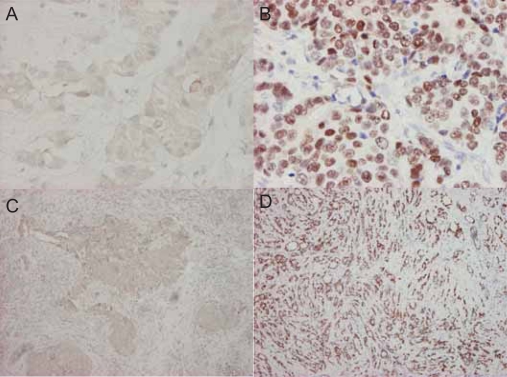
Immunohistochemical stain of ER in Taiwanese breast cancer tissues. (A) and (C) ER− 200X and 40X; (B) and (D) ER+ 200X and 40X. The microarray experiments were performed by using these examined tissues.